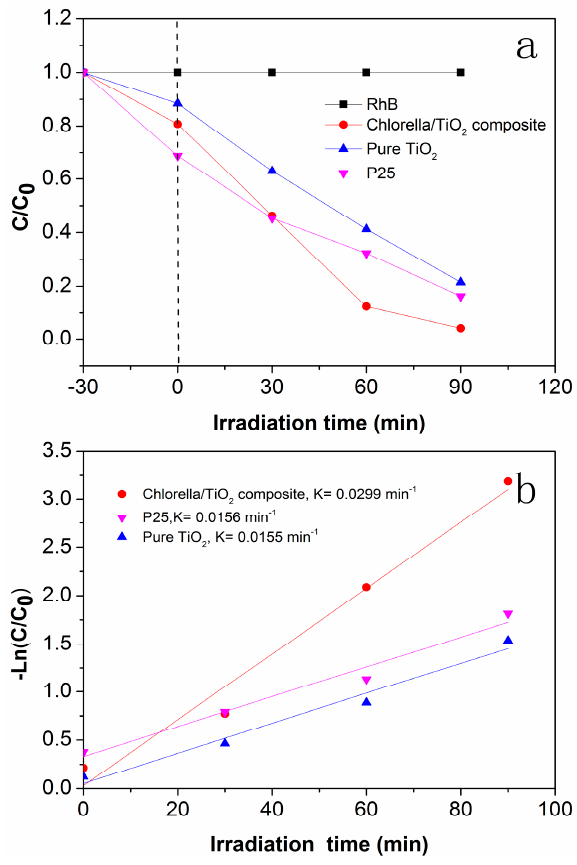
Figure 7. ( a ) Photocatalytic degradation of rhodamine (RhB) solution with the samples under visible-light irradiation; ( b ) Photodegradation kinetics lines.